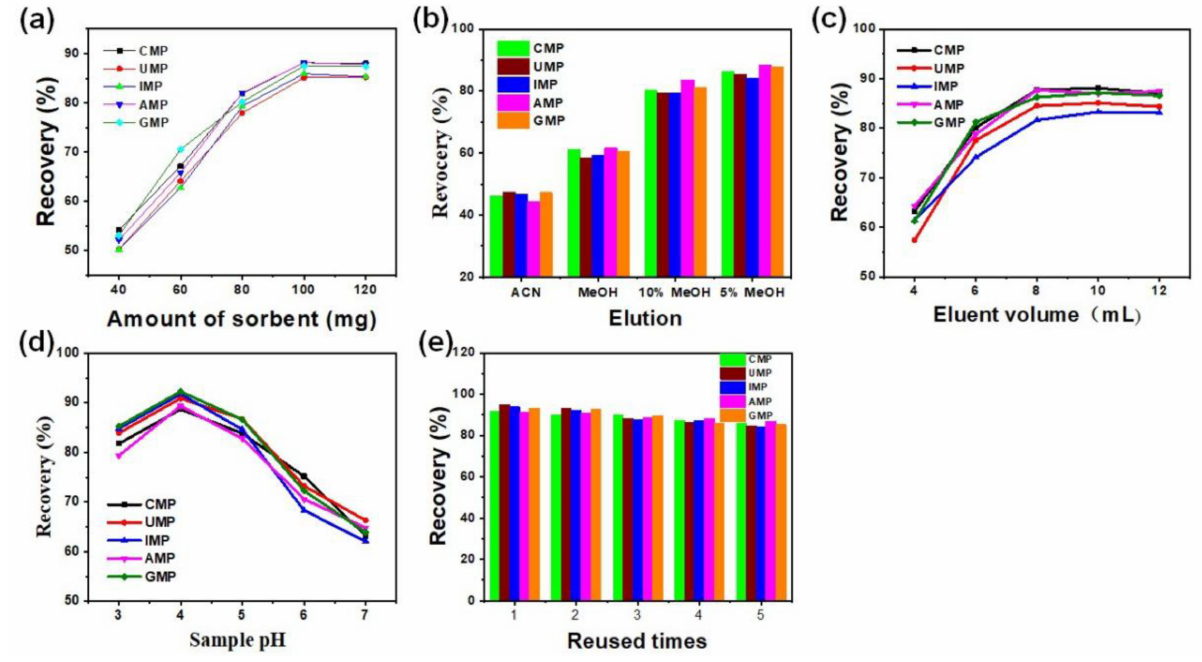
Figure 6. Optimization of solid-phase extraction conditions: ( a ) Amount of sorbent; ( b ) Type and composition of eluate; ( c ) Elution volume; ( d ) Sample pH; ( e ) Reused